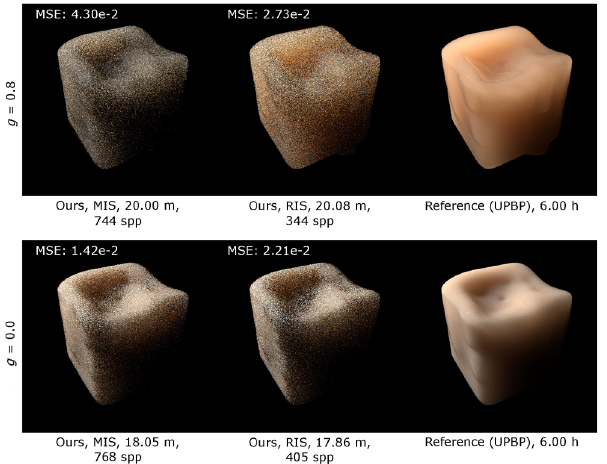
Comparison of our method with multiple importance sampling (MIS) and our method with importance resampling (RIS) on the Candle scene. Materials: g = 0.0 and g = 0.8.